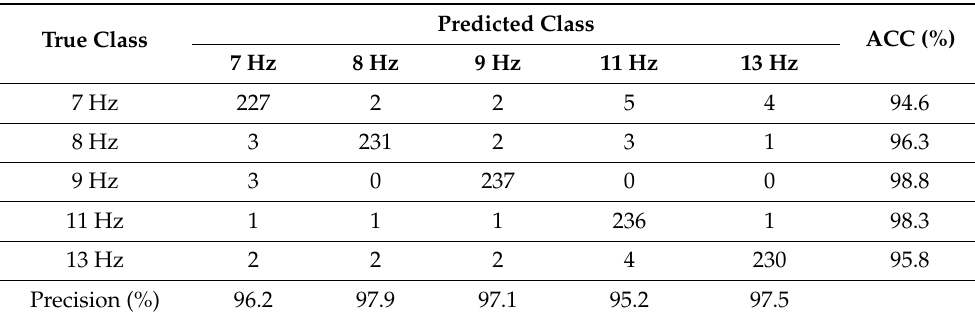
Table 8. The confusion matrix for the SSVEP recognition results using CCA classifier for the room information test in the second experiment (Scenario 2).